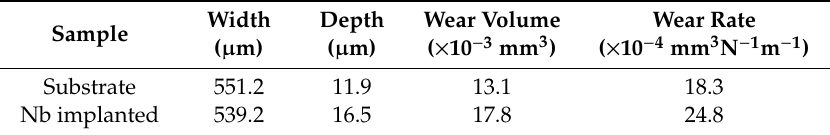
Table 3. Calculation results of wear scar of